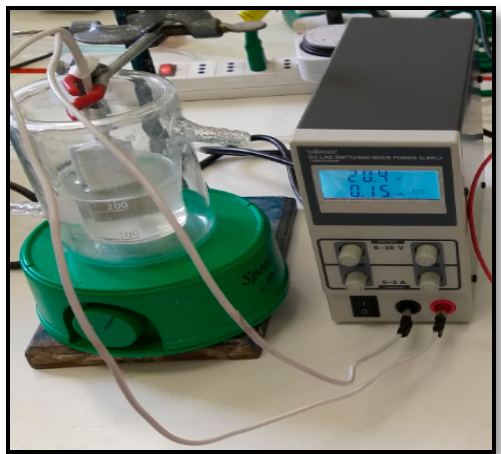
Figure 1. Electrochemical system.